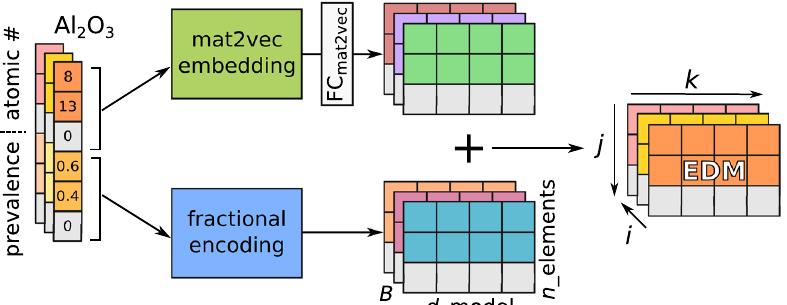
Fig. 6 EDM featurization scheme. Schematic illustration of the element-derived matrix ( EDM ) representation for Al 2 O 3 , where B represents the batch, d model is the element features, and n elements represents the number of elements. Composition slices, when concatenated across batch dimension i , form an EDM tensor which is then used as the model input to CrabNet . When a chemical formula has fewer elements than rows in the EDM , the extra data rows are fi lled with